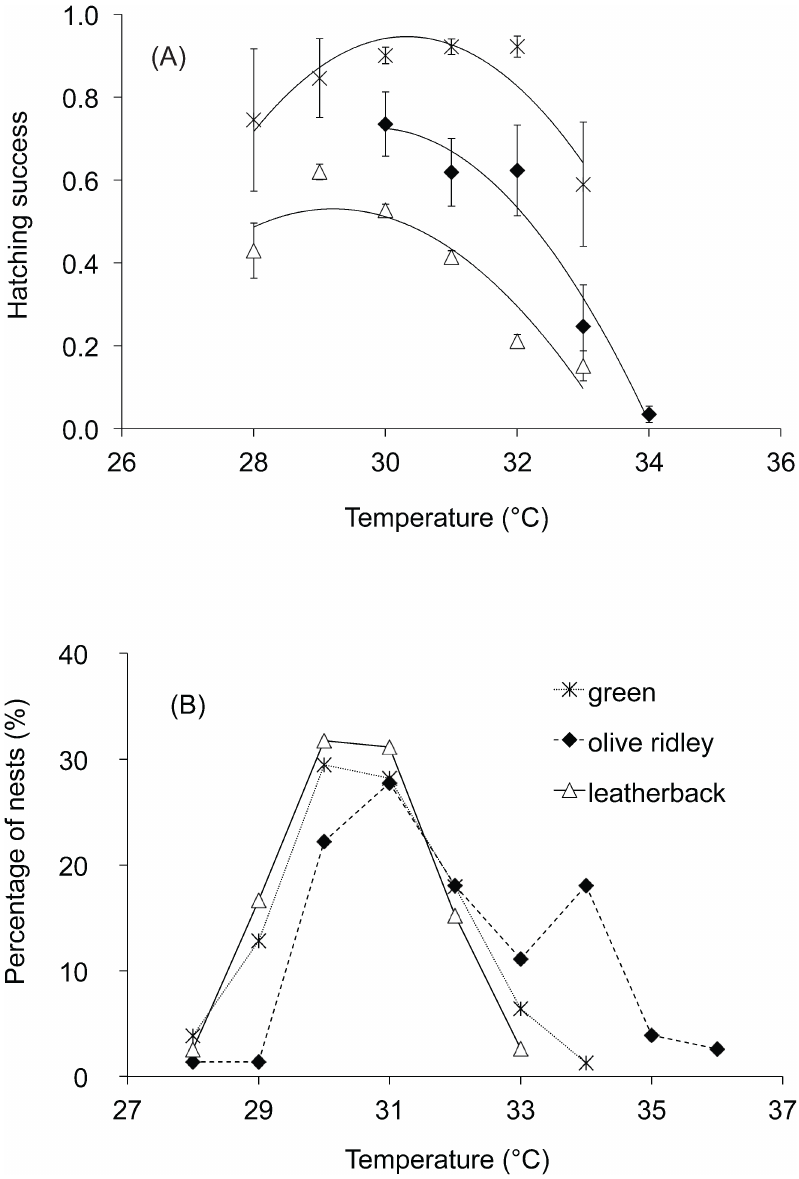
Fig 4. Mean hatching successand percentage of clutches of each species versus mean temperature (˚C). (a) Mean hatching success of olive ridley, green and leatherbackturtle clutches per mean temperature (˚C) by 1 (˚C) increments and (b) percentageof clutchesper mean temperature (˚C) by 1 (˚C) increments. Regression line in Fig 4a correspondsto a polynomial